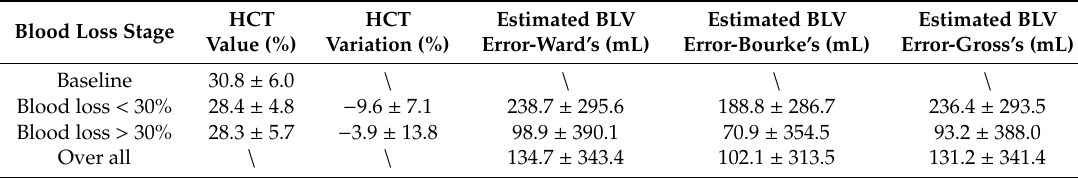
Table 2. Hematocrit (HCT) values and variations among di ff erent experiment stages.